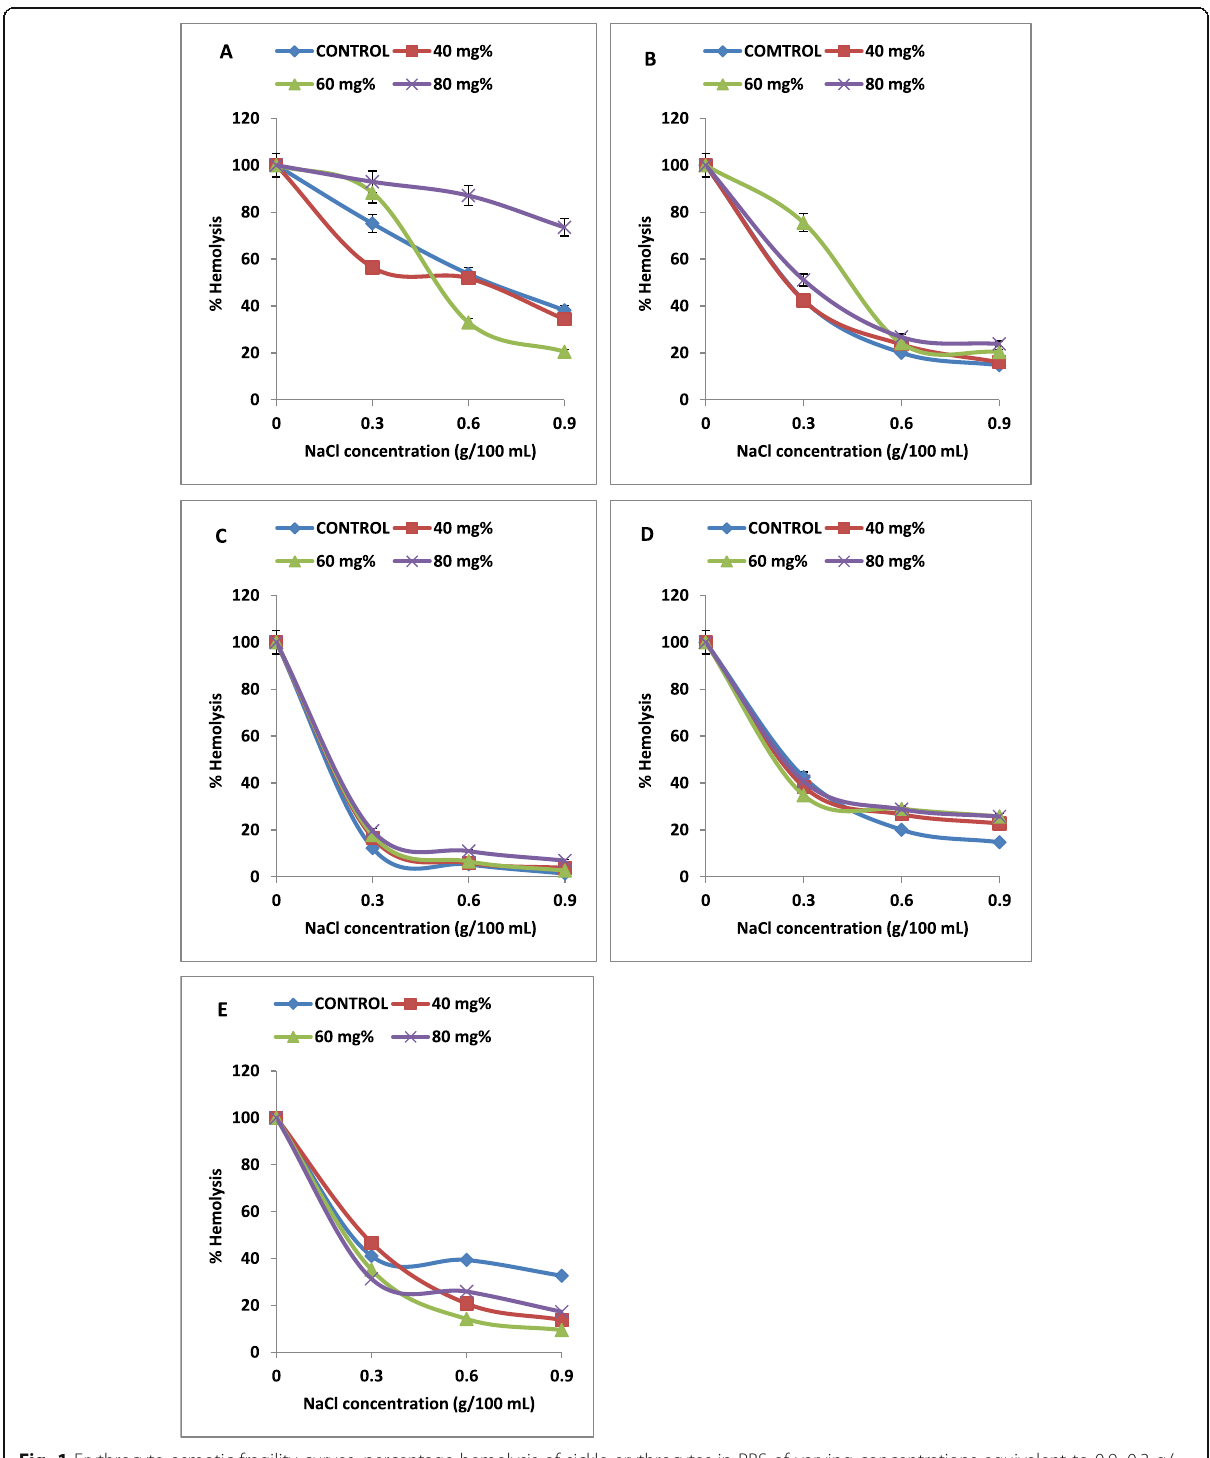
Fig. 1 Erythrocyte osmotic fragility curves: percentage hemolysis of sickle erythrocytes in PBS of varying concentrations equivalent to 0.9 – 0.3 g/ 100 mL NaCI in the presence of fractionated leaf extracts of A . occidentale . a Petroleum ether. b n -hexane. c Chloroform. d Ethylacetate. e Residual